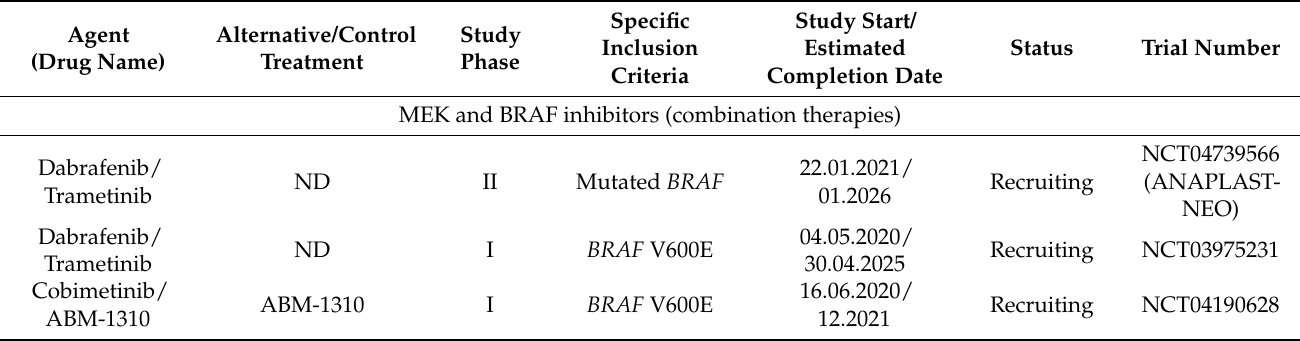
Table 3. Kinase inhibitors currently investigated in clinical trials for ATC treatment (registered under ClinicalTrials.gov and